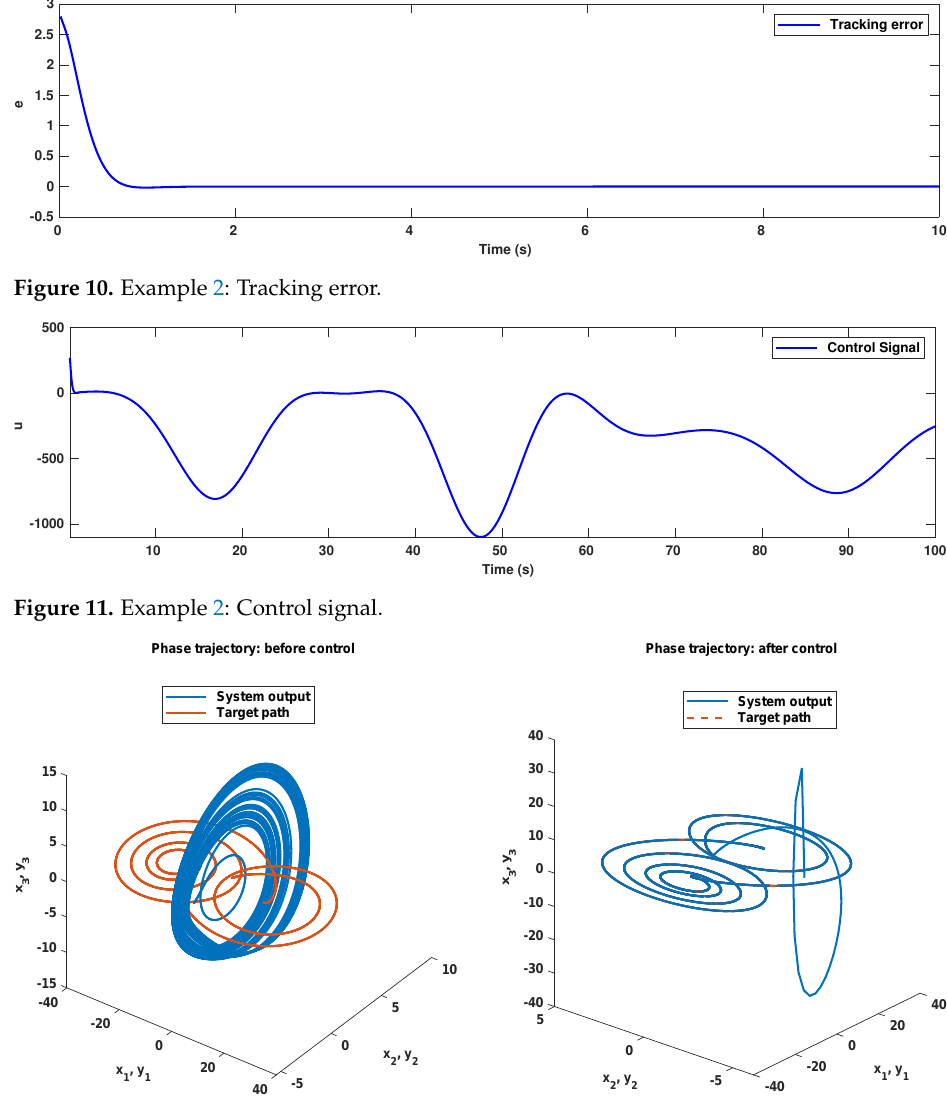
Figure 12. Example 2: Phase trajectory, after and before